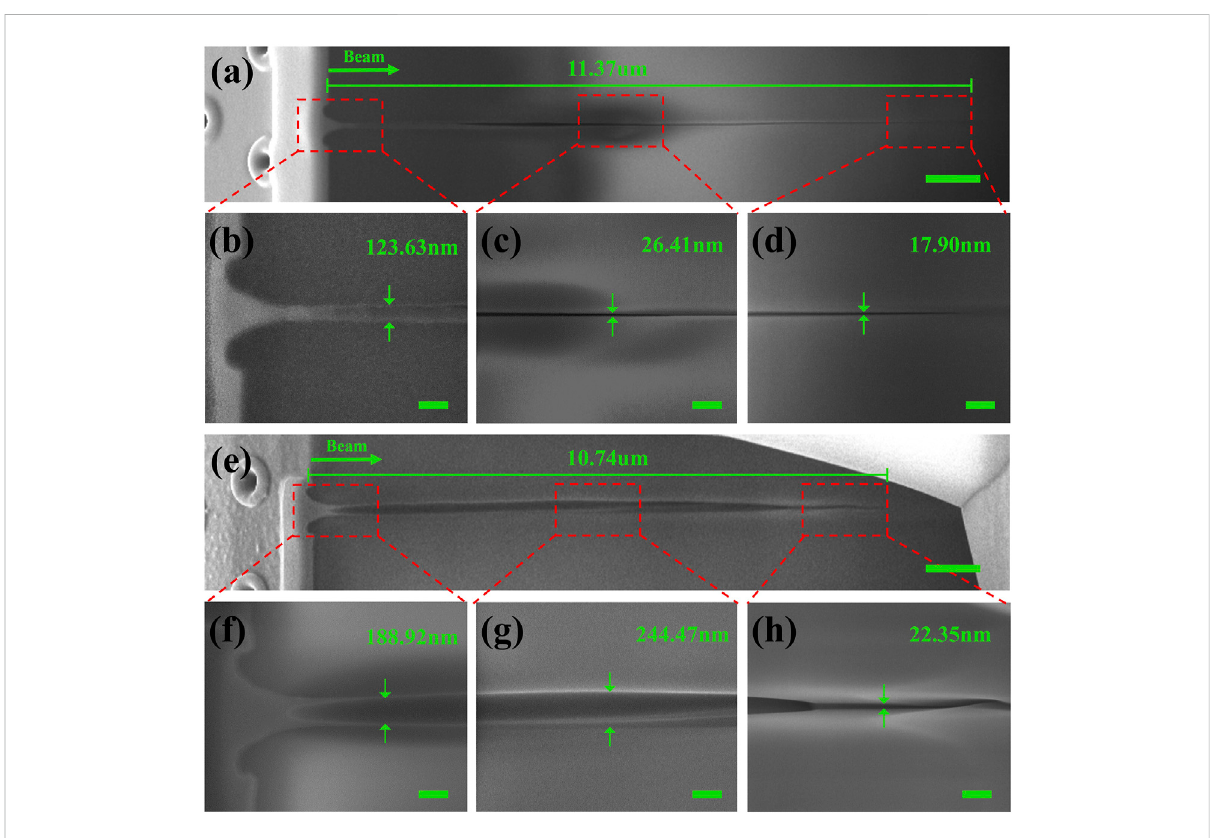
FIGURE 4 FIB pro fi le results of nanochannel two and three (surface interaction region located at Z = 2 and 5 μ m). (A) FIB results of the nanochannel two with length about 11.37 μ m (scale bar 1 μ m). The high-resolution images of the nanochannel two: (B) head region, (C) middle region, and (D) tail region (all scale bars 200 nm). (E) FIB results of the nanochannel three with length about 10.74 μ m (scale bar 1 μ m). The high-resolution images of the nanochannel three: (F) head region, (G) middle region, and (H) tail region (all scale bars 200